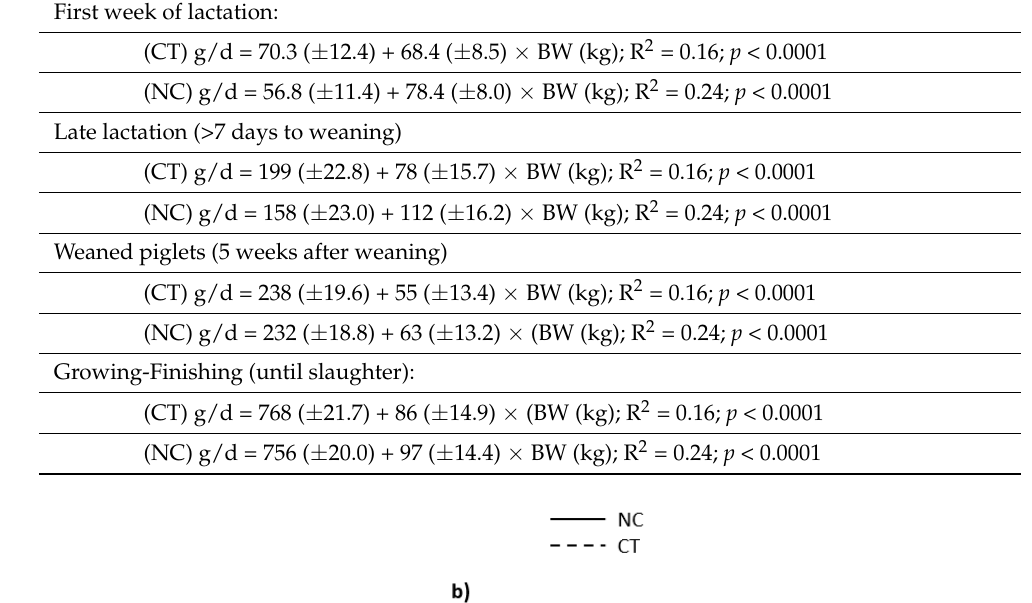
Table 2. Relationship between birth weight (kg) and daily gain (g/d) as a consequence of the presence (NC) or absence (CT) of neonatal care during: first week of lactation; late lactation (>7 days until weaning); weaned piglet (5 weeks after weaning); growing-finishing period. First week of lactation: